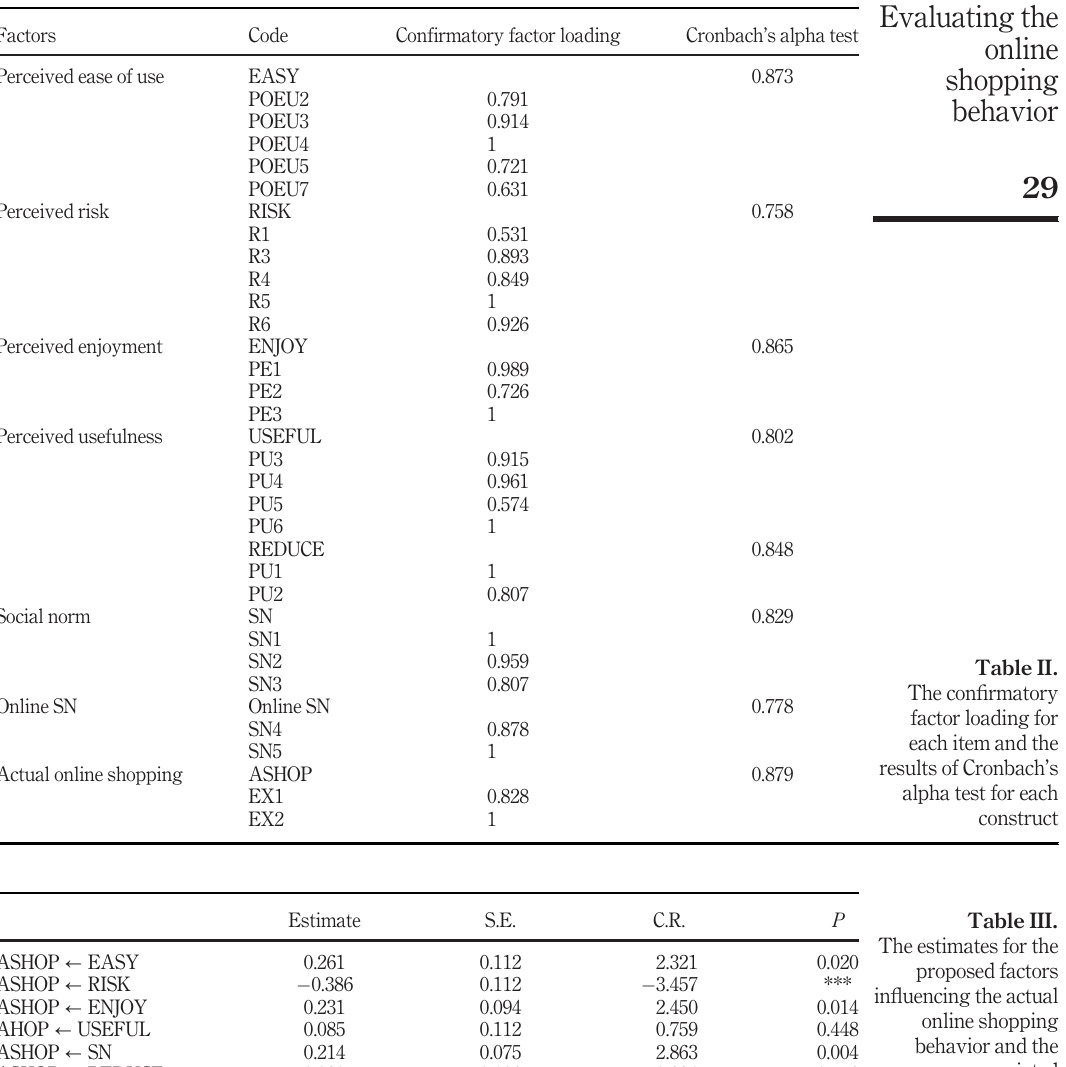
of the factors USEFUL, ENJOY and EASY. Removing all insigni fi cant relationships led to the fi nal model presented in Figure 2 including only all signi fi cant relationships. The fi t indices for the fi nal model are as follows: CMIN/df ratio = 1.632, the comparative fi t index CFI = 0.931, the adjusted goodness of fi t index AGFI = 0.839, incremental fi t index IFI = 0.932, root mean square error approximation RSMEA = 0.053.